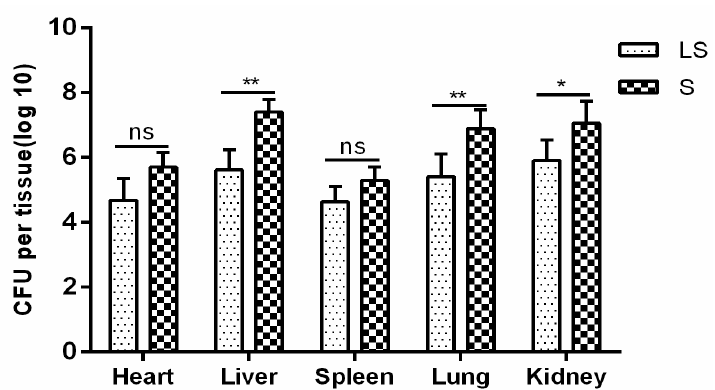
Figure 2. Tissue bacterial count. S = S. enteritidis infection group and LS = L. reteri S5 + S. enteritidis group. ns indicates that the comparison between the two groups is not significant. * means p < 0.05, ** means p < 0.01.